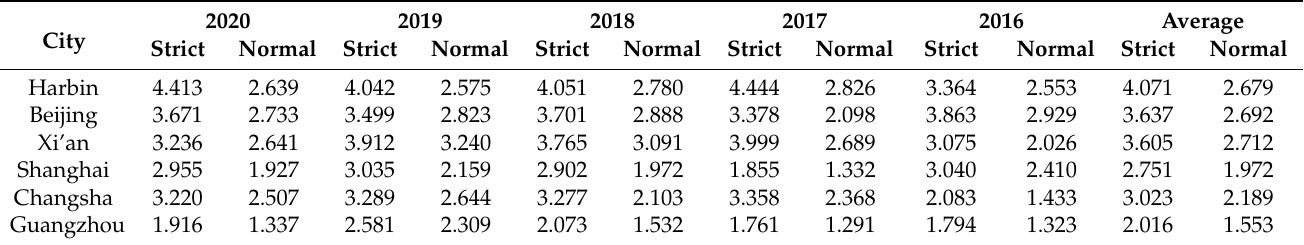
Table 4. The recommended coefficient K values for six typical cities from 2016 to 2020.